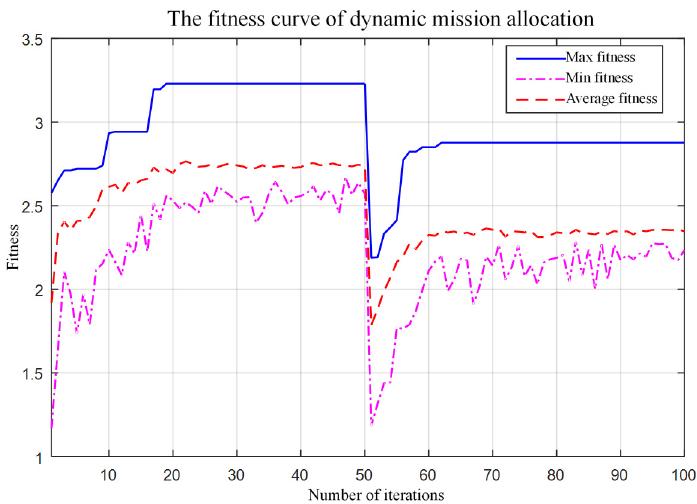
Figure 6. The change curve of fitness before and after UAV sudden failure.